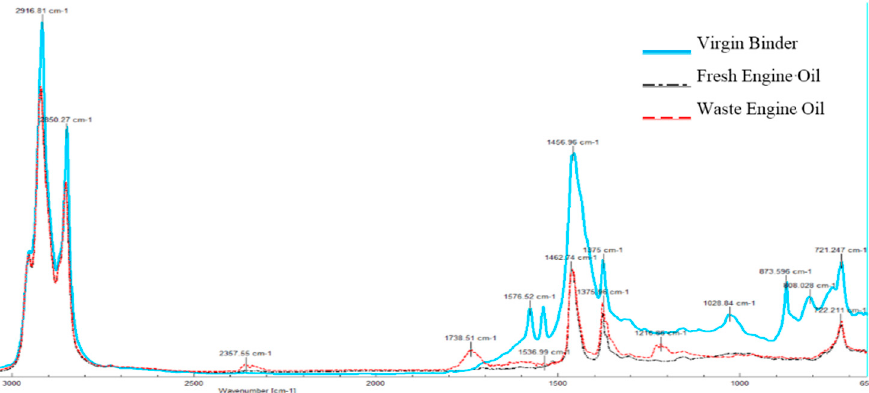
Figure 2. Chemical composition of asphalt binder, fresh engine oil and waste engine oil.